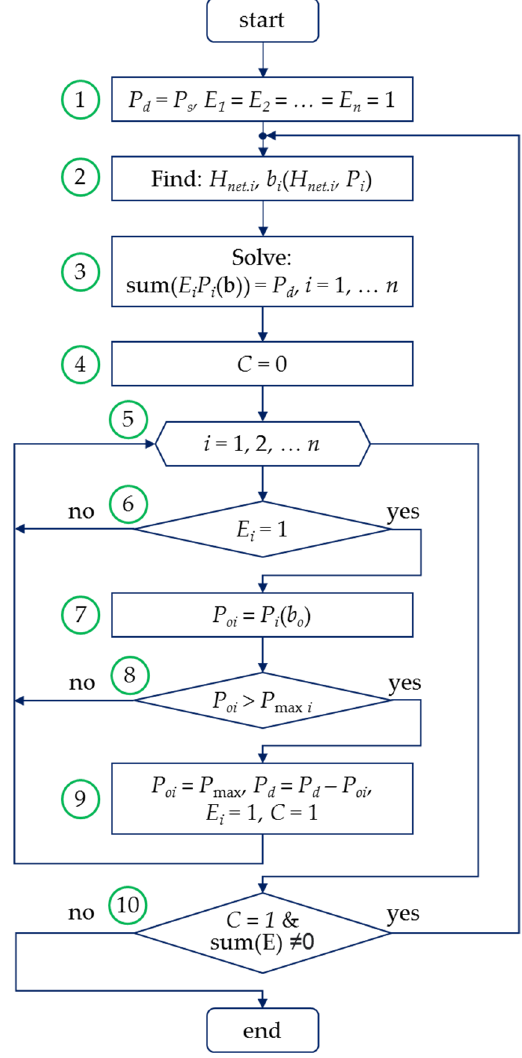
Figure 3. The flowchart of the algorithm for optimal power distribution on the criterion of equality of incremental turbine discharges with consideration of head losses in a trash rack.